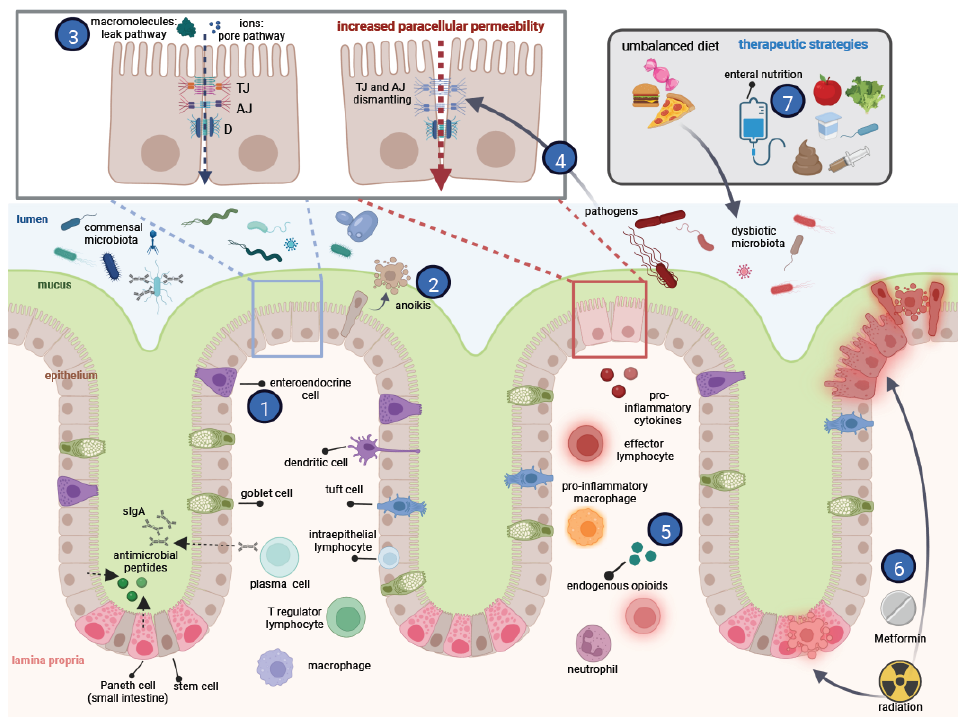
Figure 1. Actors and regulation of gut barrier function. The central actor of the intestinal barrier is a single-monolayer epithelium, which undergoes a rapid renewal from stem cells (located at the bottom of crypts) followed by the differentiation of proliferating cells into several specialized cell types. Cells of the absorptive lineage (enterocytes/colonocytes) ensure nutrient absorption, whereas the secretory lineage comprises several cell types involved in other gut functions, including its barrier function: Paneth cells (in the small intestine but not the colon) synthesize antimicrobial peptides,